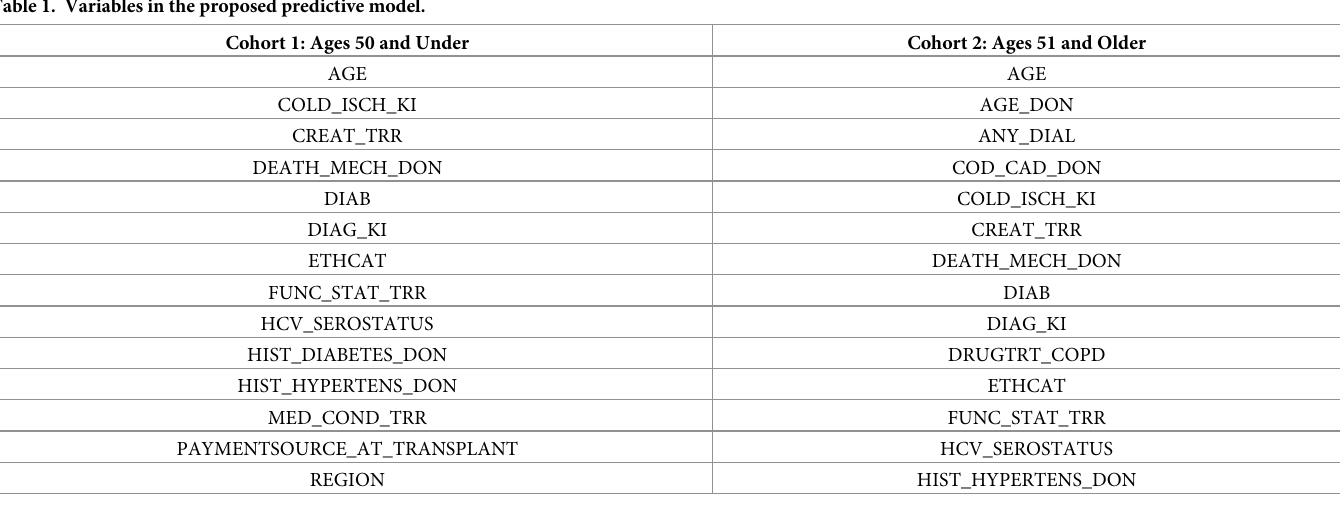
Table 1. Variables in the proposed predictive